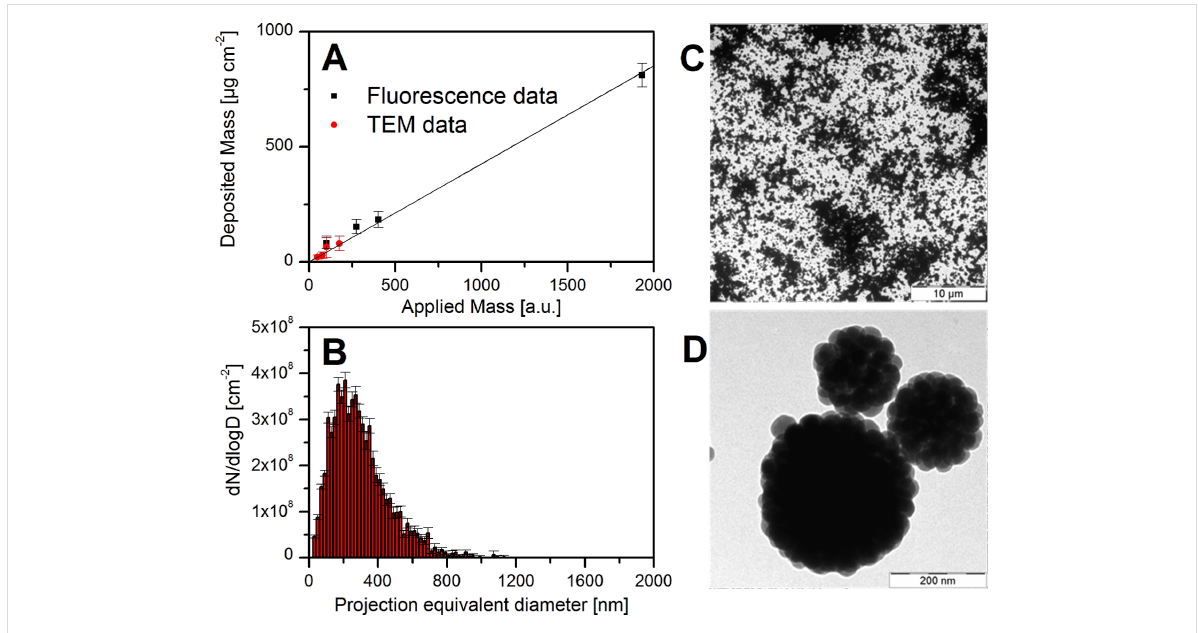
Figure 5: Characteristics of deposited SiO 2 -50 nm agglomerates. Aerosols of fluorescently labeled SiO 2 -50 nm agglomerates were generated by an atomizer and deposited on Transwell membranes with an applied electrostatic field. The deposited mass was either detected by measuring fluores- cence intensity or using TEM analysis of particle loaded grids. (A) shows the deposited mass as a function of the applied mass by the two detection methods. The size distribution of the corresponding particles on a TEM grid is shown in (B). (C) shows the particle loading on TEM grids after seven hours of exposure corresponding to a mass dose of (117 ± 46) µg·cm − 2 and (D) representative clusters at higher magnification indicating the spher- ical agglomerate shape. Please note that the applied mass in (A) is given in arbitrary units (third power of the mobility equivalent diameter) and neither the effective density nor the total particle size range was considered. Hence the slope of the linear fit is not equal to the mean mass deposition effi- ciency.